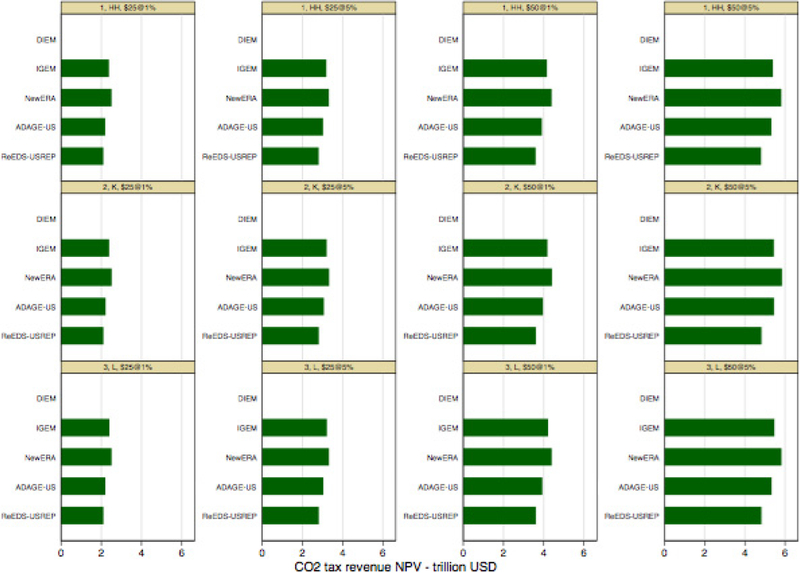
Large agreement regarding CO2 tax revenue across
models, revenue recycling scheme, and CO2 price path.